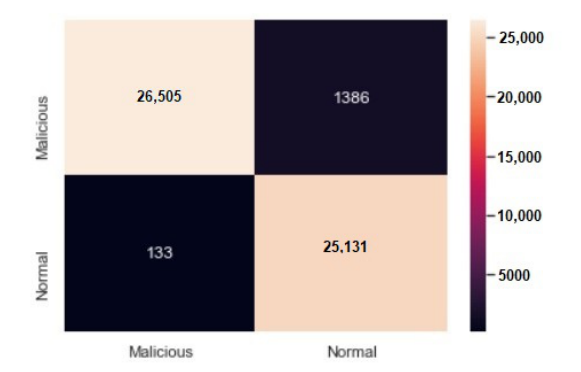
Figure 14. Confusion matrix for DDoS detection model tested.